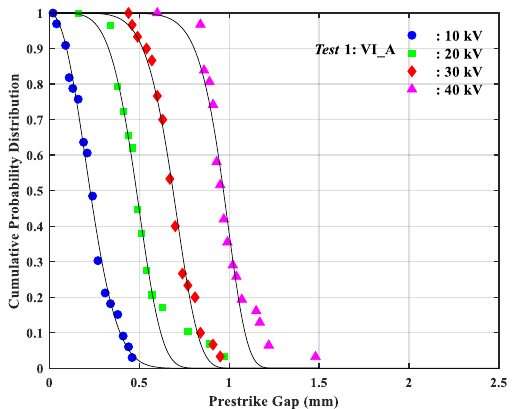
Figure 4. The complementary cumulative distribution function of prestrike gaps in Test 1.